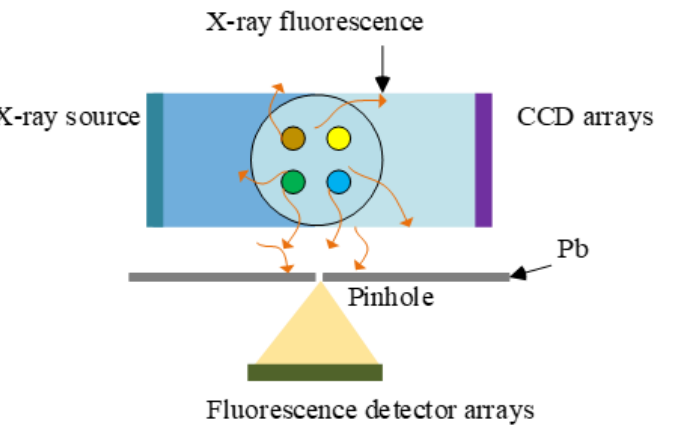
Figure 1. Schematic diagram of XFCT imaging system based on pinhole collimator with sheet ‐ beam . The X ‐ rays are shaped into parallel sheet beams by a lead collimator, incident on the phantom and cover the entire imaging section. Then, fluorescent X ‐ rays are emitted iso ‐ tropically due to the interaction of X ‐ rays with high Z elements. The X ‐ rays that pass through the pinhole are recorded by linear array detectors with energy resolution. All recorded data are stored on the computer for image reconstruction.